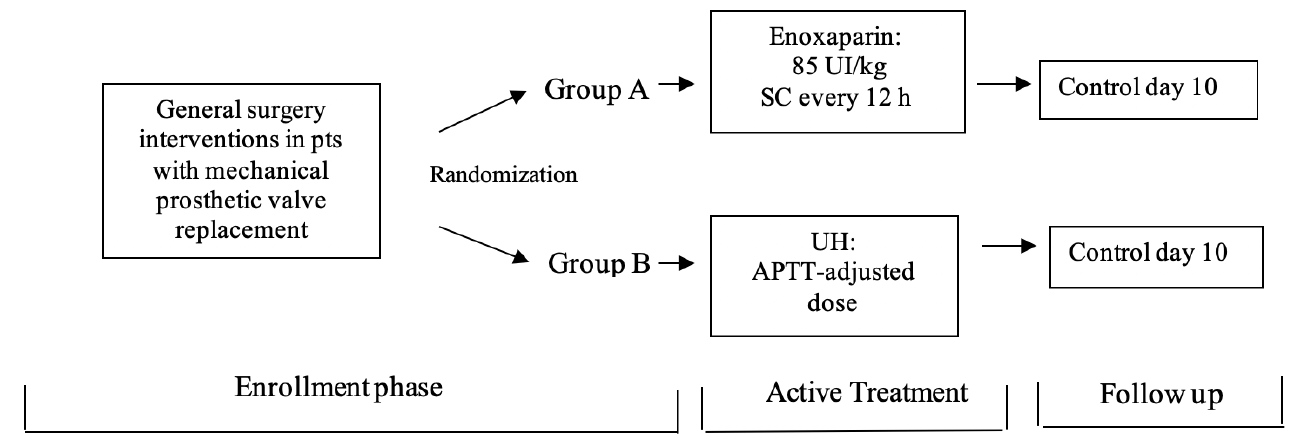
Figure 1. Study protocol phases. SC—subcutaneous; UH—unfractionated heparin; APTT—activated partial thromboplastin time.